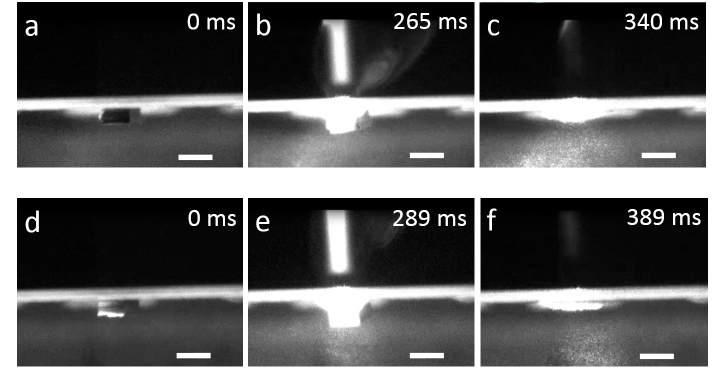
Figure 8. Releasing of chips from a thermal tape by firing a laser beam. ( a , d ) 500 μ m × 500 μ m × 300 μ m chips were attached to a thermal release tape; ( b , e ) the chips were moved under the laser beam and the laser beam was fired at the chips; ( c , f ) the tape was heated to its curing temperature by the laser beam and the chips were released from the thermal release tape (Supplementary Video S2). Scale bar: 500 µ